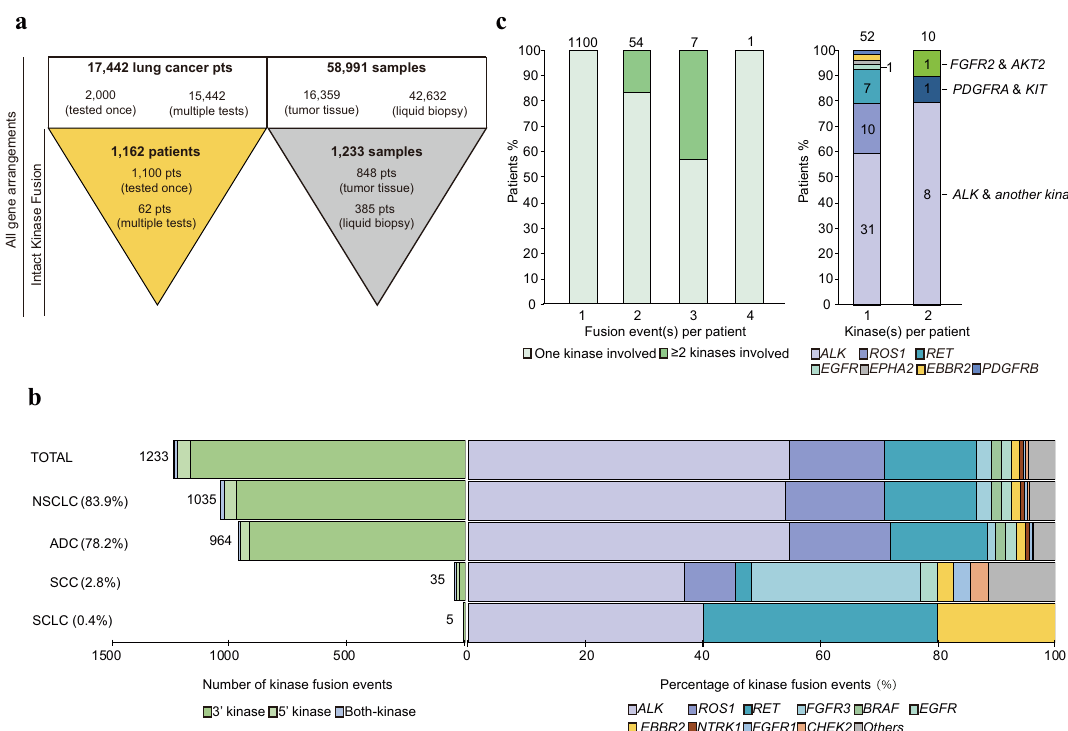
Fig. 1 Overview of kinase fusions in lung cancer patients. a Pipeline for kinase fusion calling and fi ltering. b The left bar plot shows the distribution of the three kinase fusion categories in different lung cancer subtypes. The number of events in each condition is indicated to the left of each bar. The right bar plot shows the percentage of the kinase genes involved across different lung cancer subtypes. c The left bar graph shows the number of kinase fusions in one patient. The right bar graph shows the kinase genes of patients who carried more than one kinase fusion. The number of patients in each condition is indicated on the top of each bar.